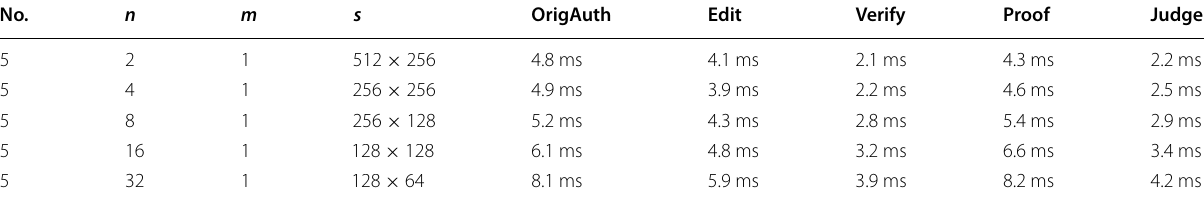
Table 3 The time cost of test images with different number of areas No.